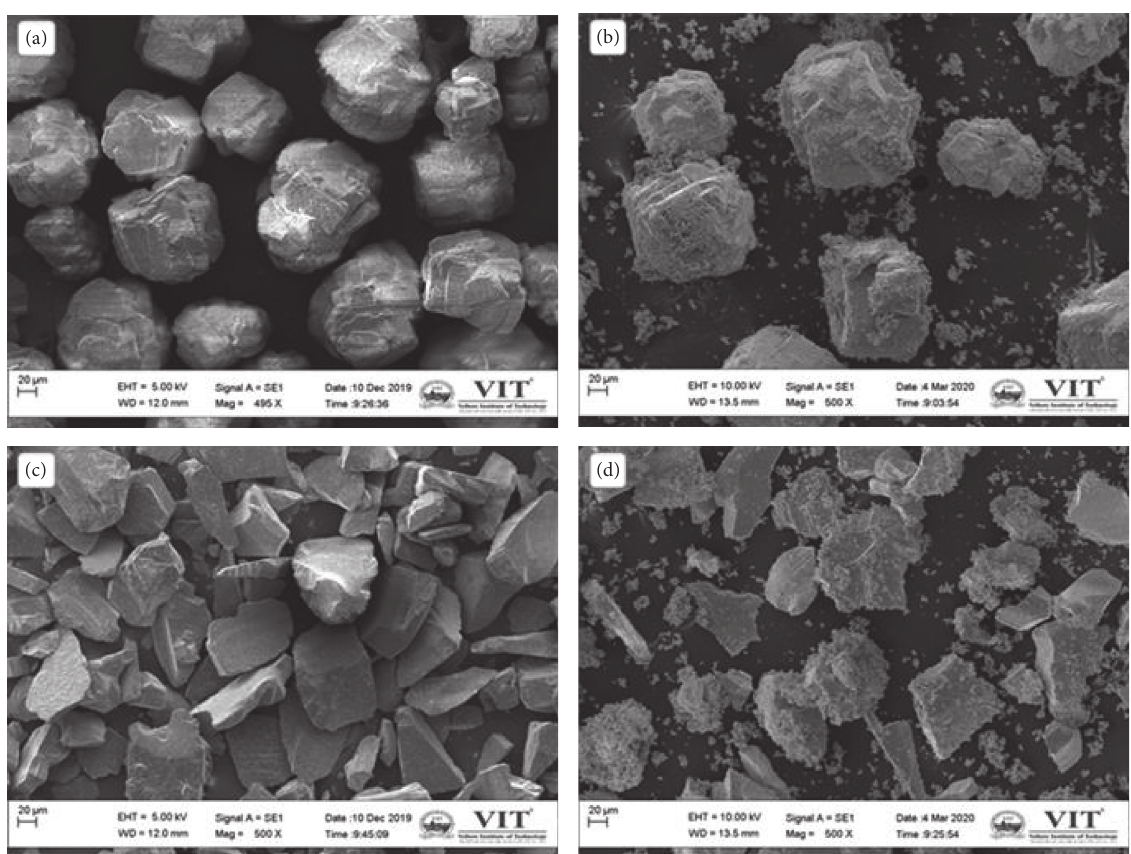
Figure 1: Surface morphology of coated and uncoated particles. (a) Uncoated Al